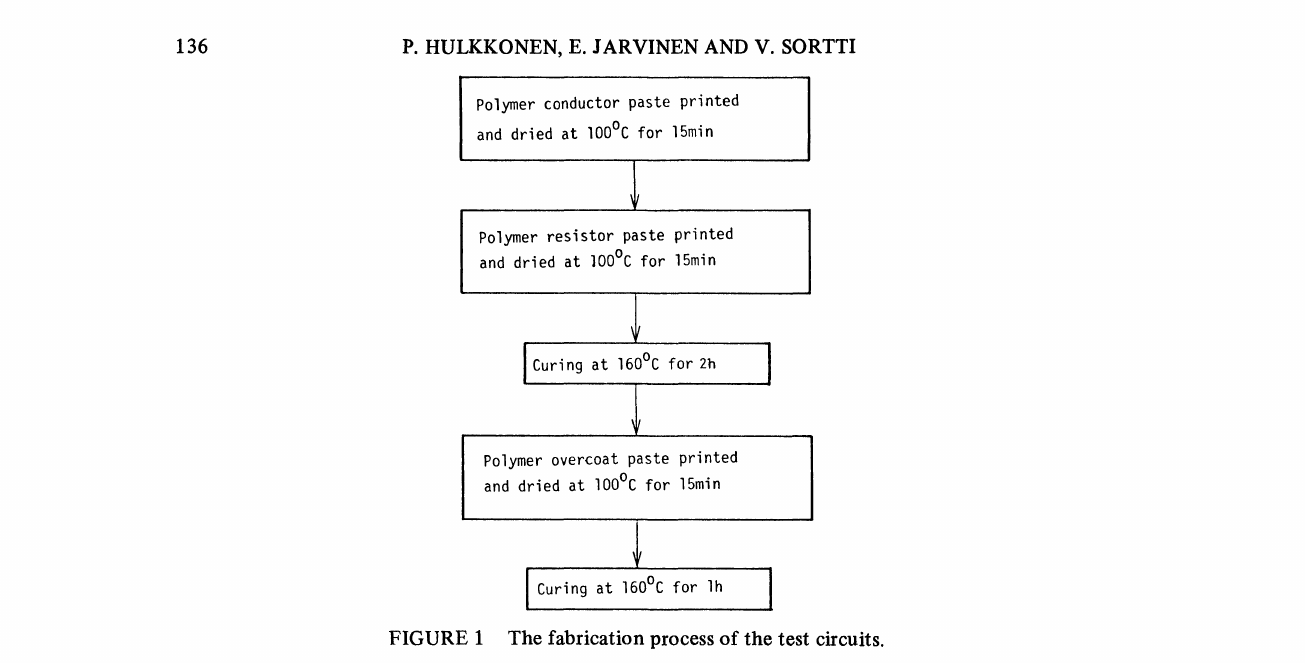
Curing at 160C for lh FIGURE The fabrication process of the test